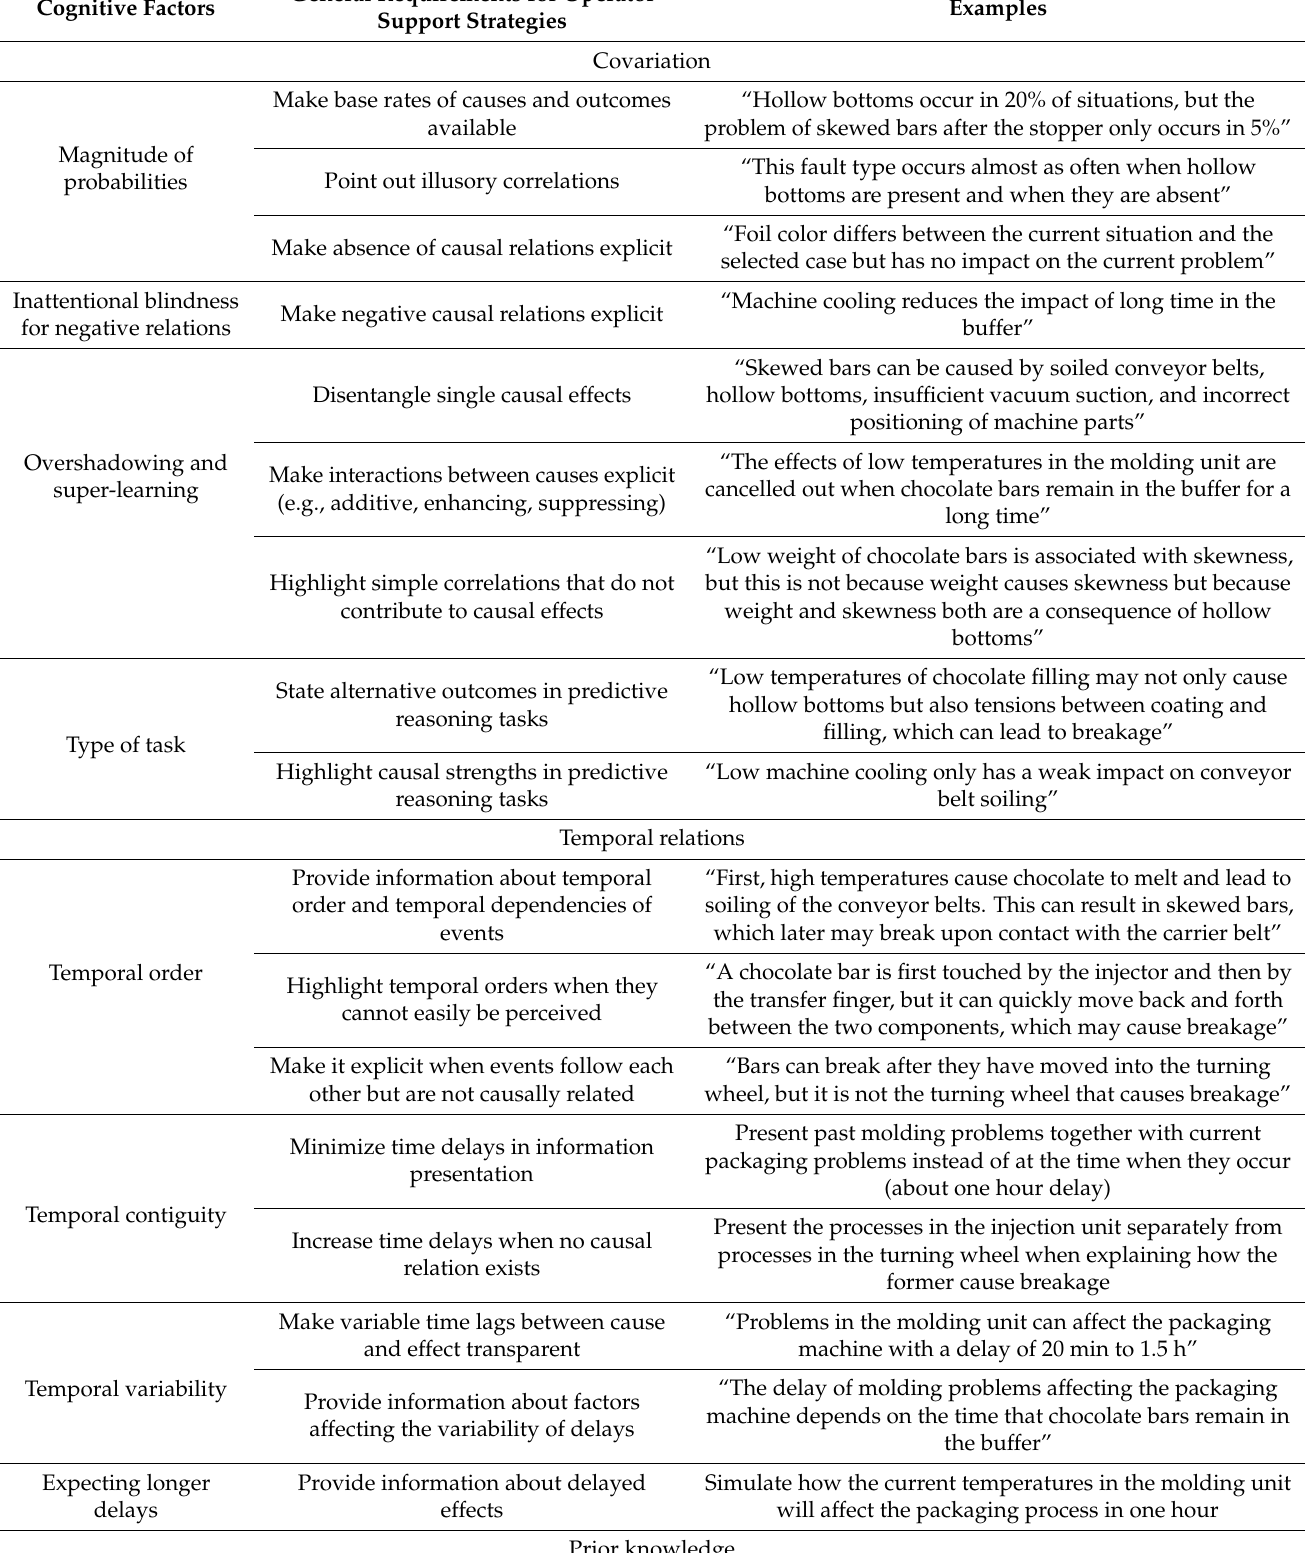
Table A4. Reasoning about